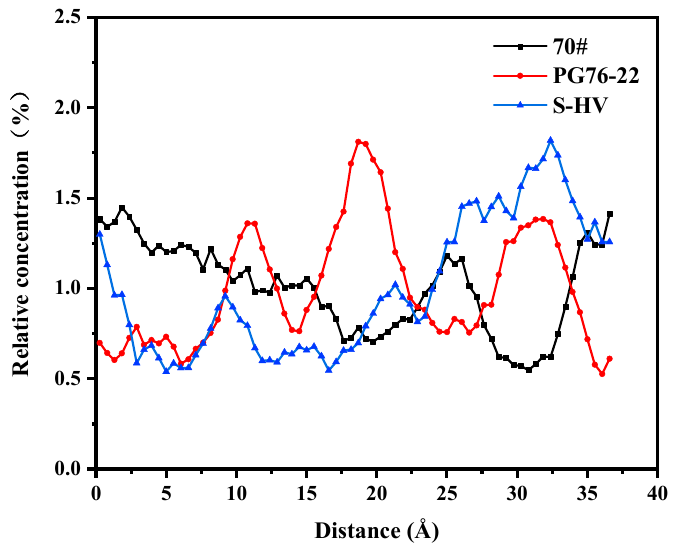
Figure 11. Solubility distribution of saturates.